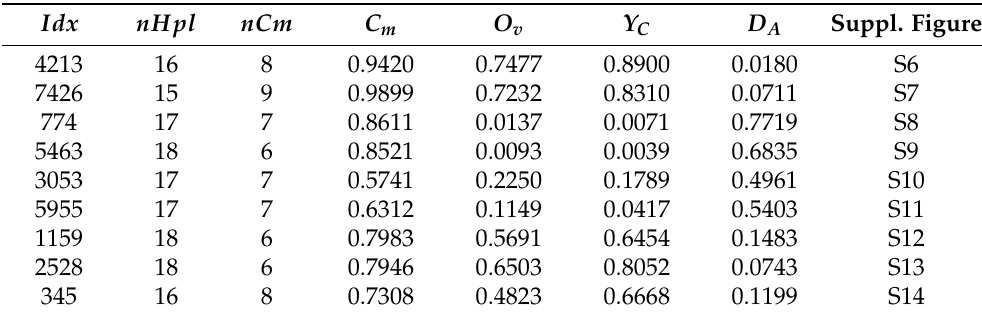
Table 5. Summary of selected examples. Idx index of the simulated quasispecies pair, nHpl number of total haplotypes in the pair, nCm number of haplotypes in common, C m , O v , and Y C similarity indices, D A genetic